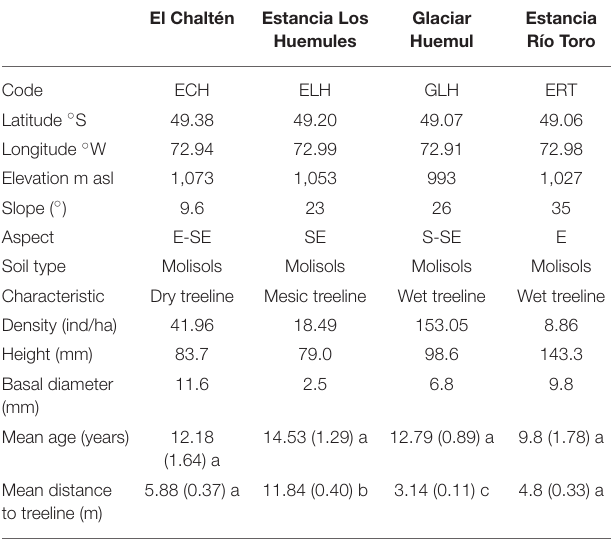
TABLE 1 | Geographic location and characteristics of sample